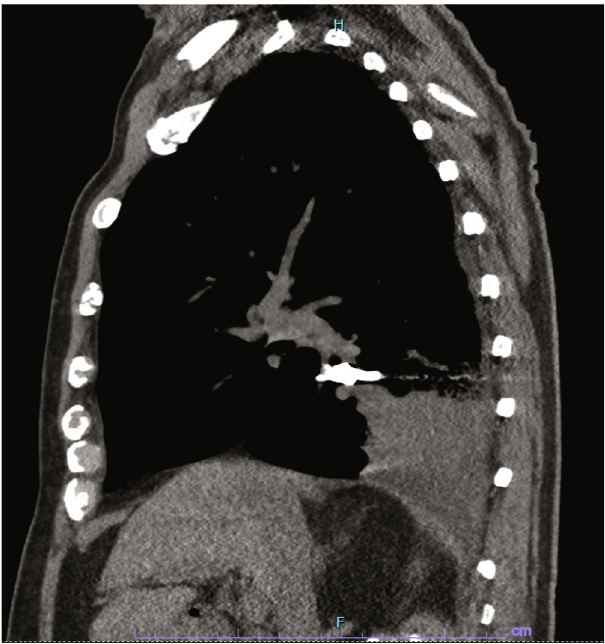
Figure 4: CT chest (sagittal view) with a metallic object and RLL consolidation.